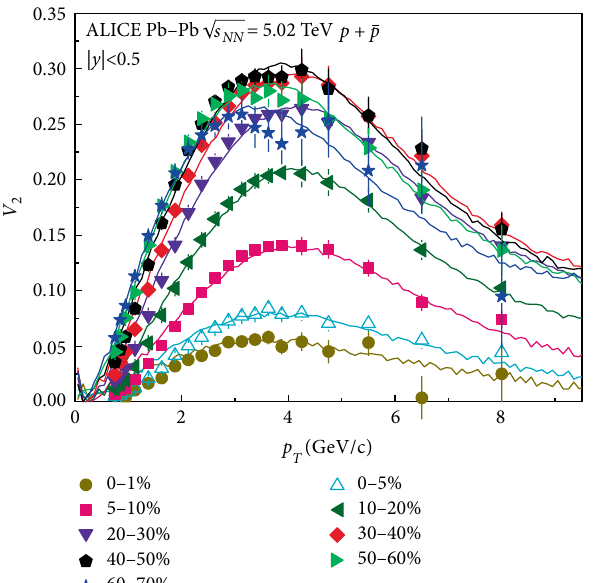
Figure 5: As for Figure 1, but showing 𝑣 centrality